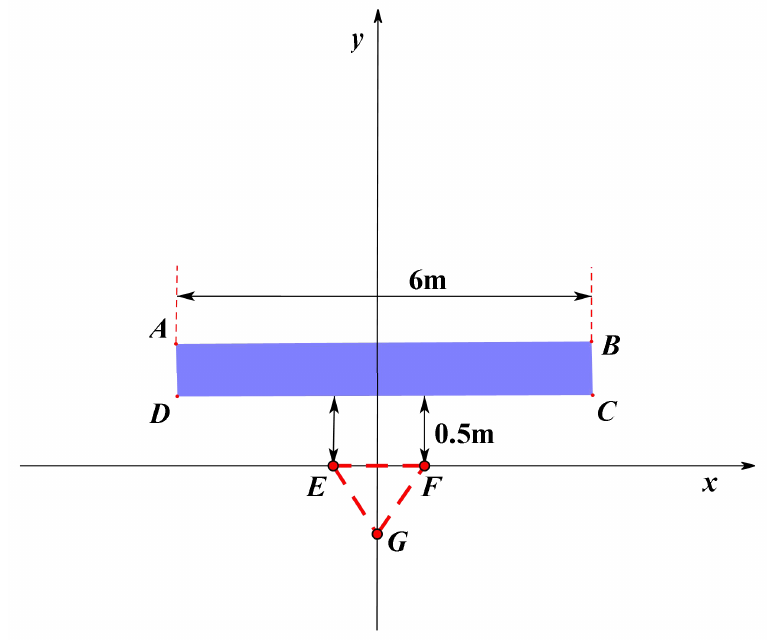
Figure 8. Relationship between the target and the LHCP antenna in the second experiment.